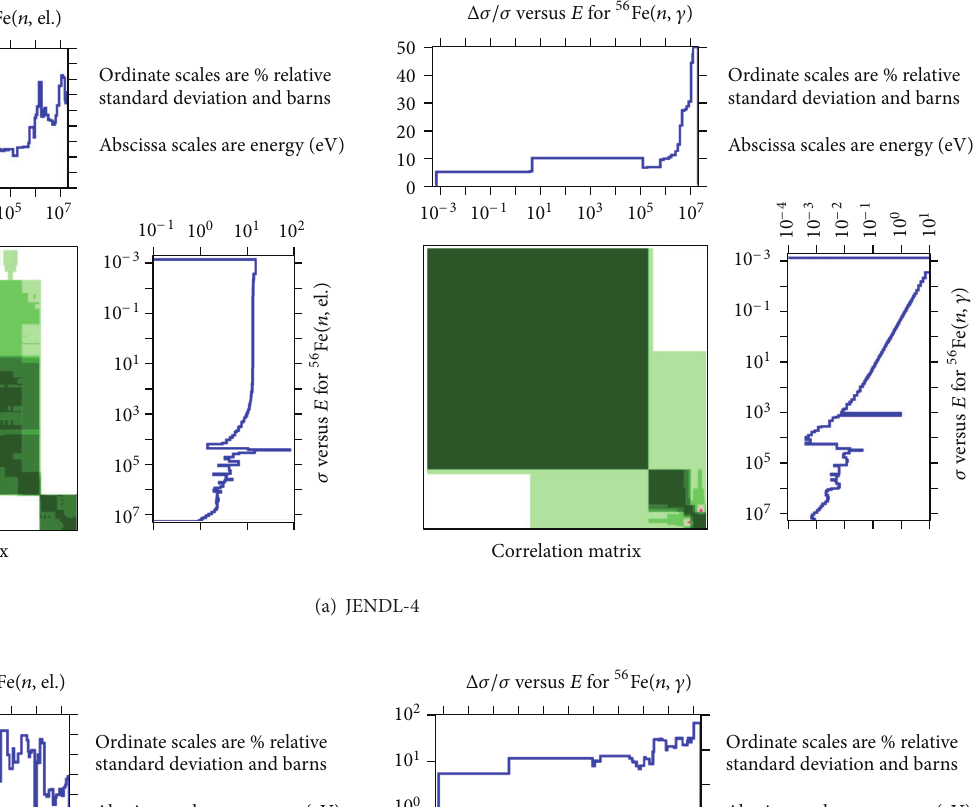
Ordinate scales are % relative standard deviation and barns Abscissa scales are energy (eV) 2 1 3 4 10 1 10 0 10 − 10 − 10 − 10 −